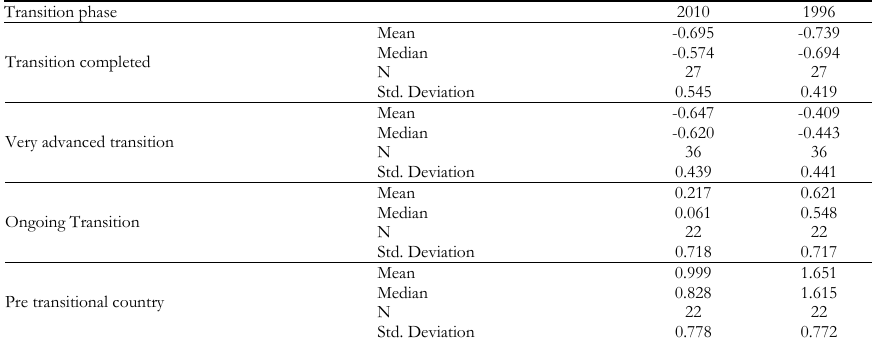
Mean and median scores for factor 1 by transition phase Transition phase